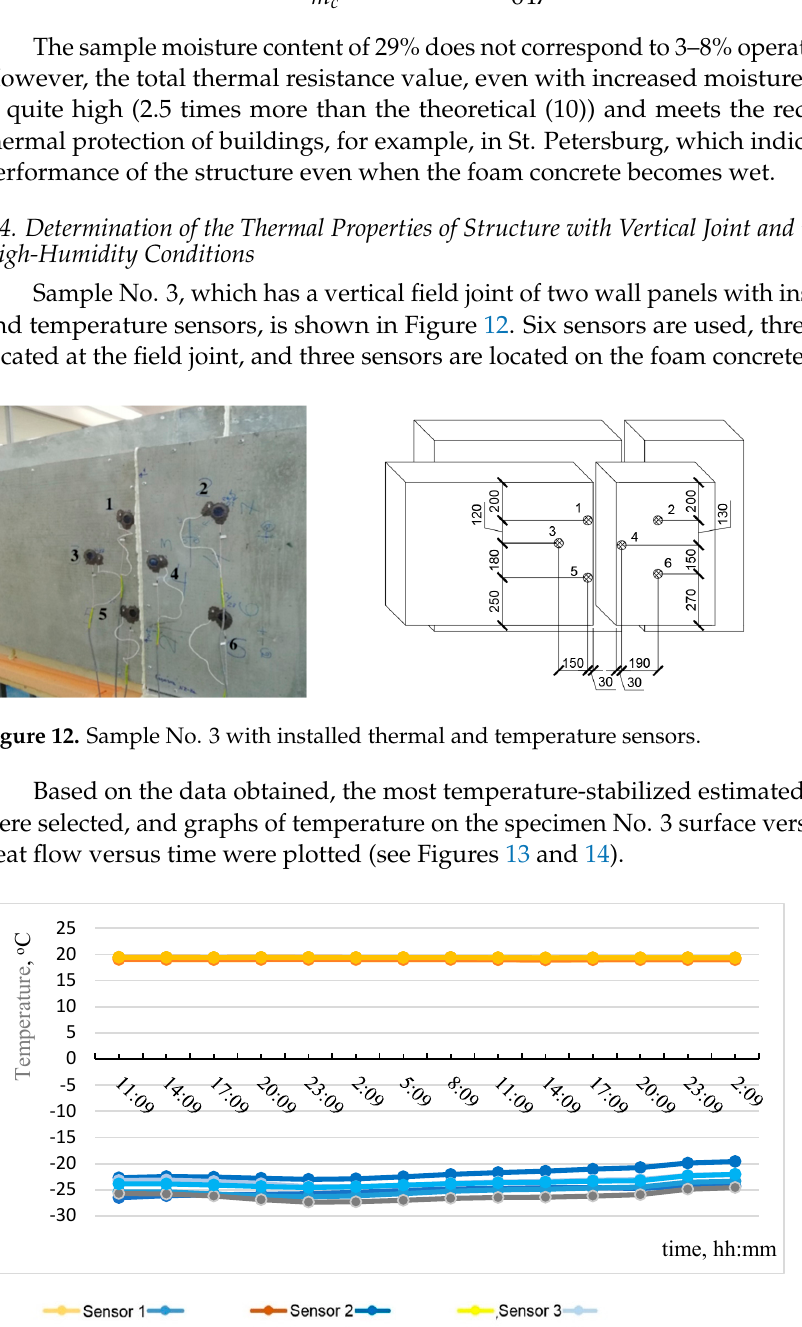
Figure 13. Temperature on the specimen No. 2 surface with time.